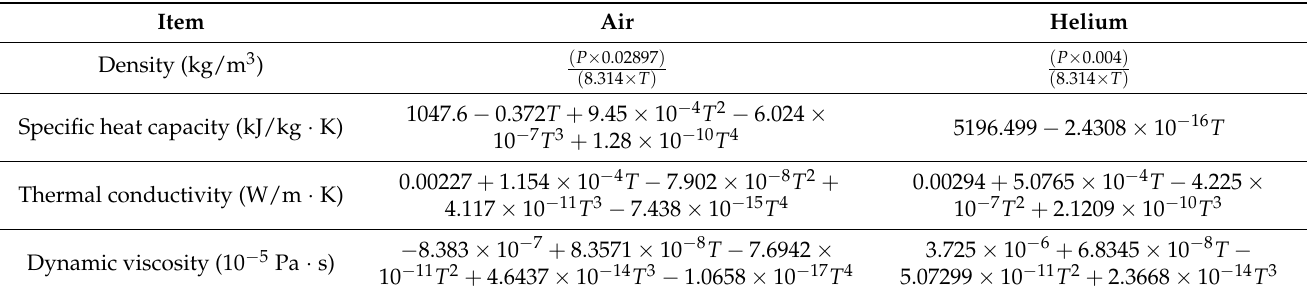
Table 1. Material properties of gases and the cooling box.